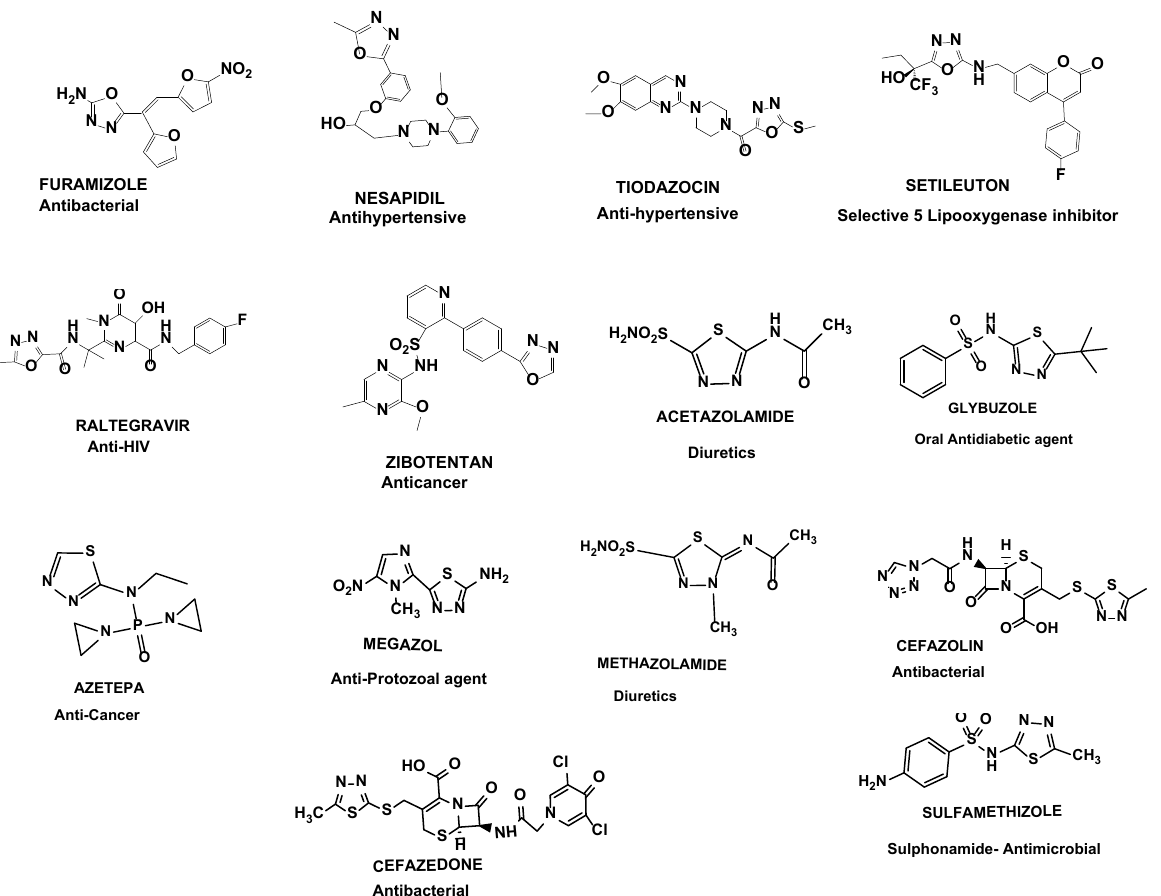
Figure 2. 1,3,4-oxadiazole/thiadiazole drugs .